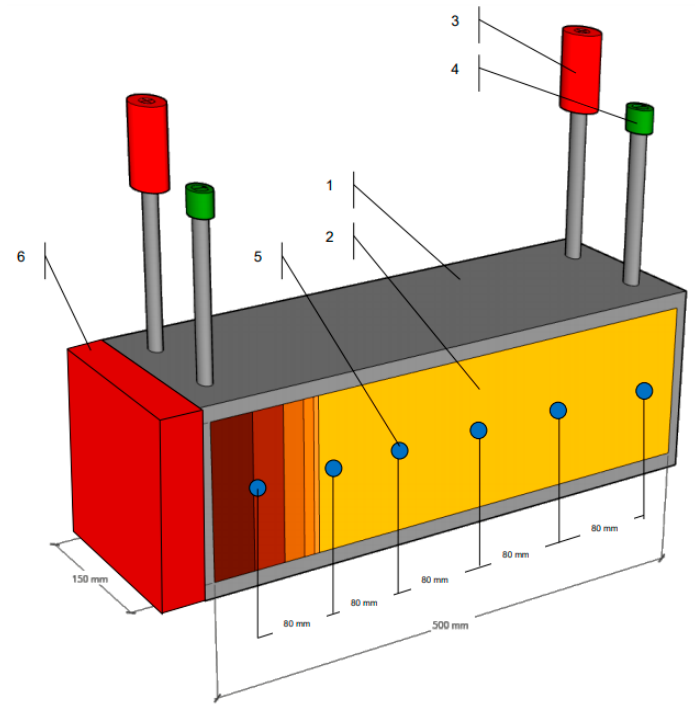
Figure 11. Insulation thickness relative to unexposed bulkhead surface temperature.